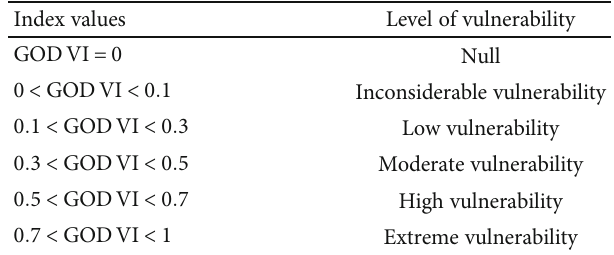
Table 3: GOD vulnerability